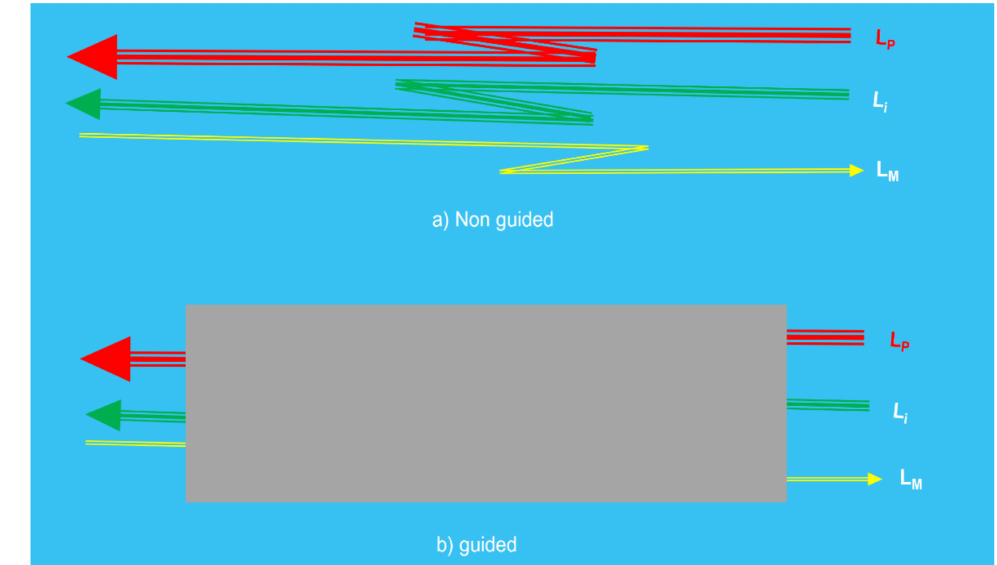
Figure 2. Illustration of the optical channel of a photonic sensor. According to the media used to transmit the Light to and from the object: ( a ) non guided optical channel and ( b ) waveguide optical channel (typically optical fiber cables). Courtesy of the author.